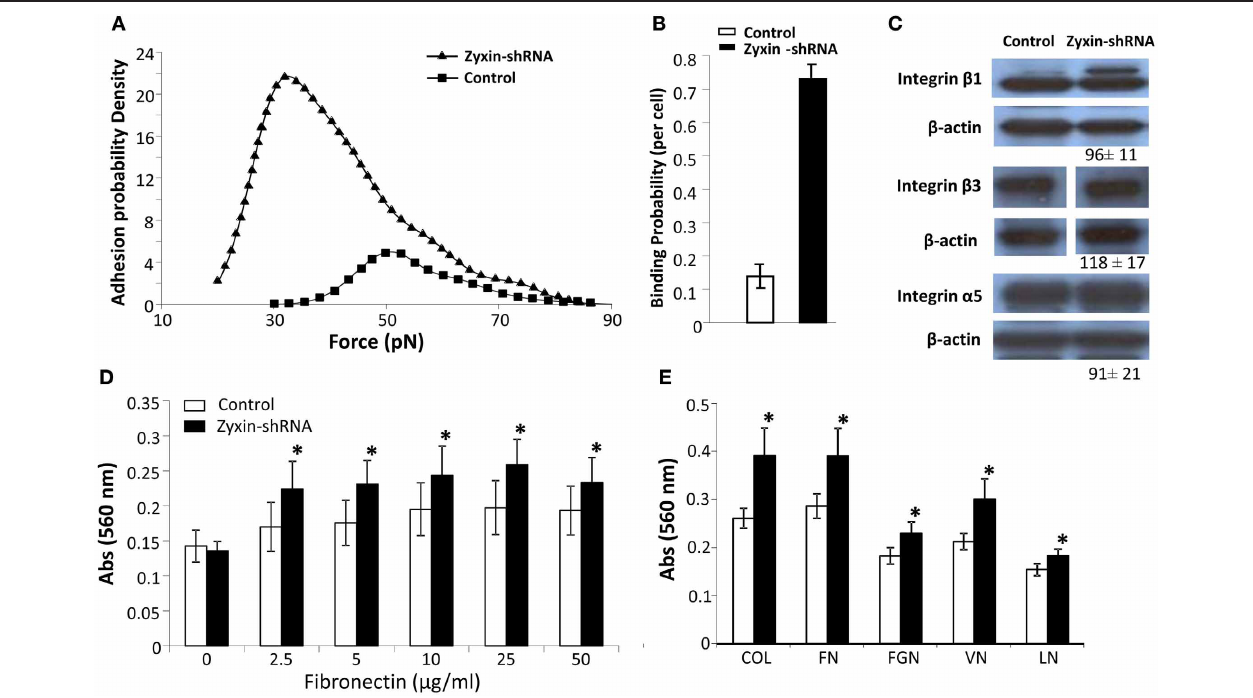
FIGURE 5 | Zyxin silencing enhanced VSMC adhesion. (A) Distribution of integrin-FN adhesion force (unbinding or rupture forces) measured using atomic force microscopy adhesion assay. (B) Zyxin-shRNA cells exhibited an increased binding probability to fibronectin. The binding probability was calculated as: number of force curves with adhesions/the total number of force curves recorded. (C) The expression level of a5, b1, and b3 integrins was not altered by zyxin silencing as compared to control VSMC. Control and Zyxin-silenced samples were run on the same immunoblot and were from the same film exposure. (D,E) Zyxin silencing